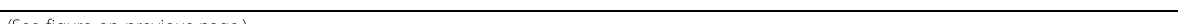
(See figure on previous page.) Fig. 2 Pedigree, clinical phenotypes and mutation analysis in family 2741. a Pedigree of family 2741 with congenital mixed hearing impairment and sensorineural hearing impairment cases (Affected subjects are denoted in black. Arrow indicates the proband. Mutation carrier are denoted with dot within a symbol); b Audiograms of both ears for the proband, who exhibited typical audiometric features of mixed hearing impairment; c Temporal bone CT images of the proband demonstrating dilation of the bottom of the IAM and a deficit in the bony plate, which separates the basal turn of the cochlea and the IAM (arrow); d Audiograms of both ears from the uncle of the proband, who shows profound sensorineural hearing impairment; e Temporal bone CT images of the uncle of the proband demonstrating dilation of the lateral end of the IAM and bone deficiency between the basal turn of the cochlea and the IAM (arrow). f Wild-type sequence of POU3F4 including position 973; g A heterozygous c.973delT mutation was found in the female carriers; h A hemizygotic c.973delT mutation was detected in the affected males; i Amino acid change caused by changes in the DNA sequence leading to a predicted frameshift mutation and truncation of the POU3F4 protein; j Panel